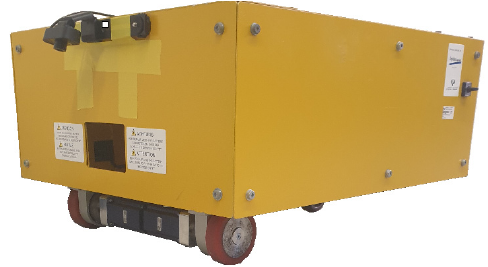
Figure 1. The AGV for which the algorithm is proposed.